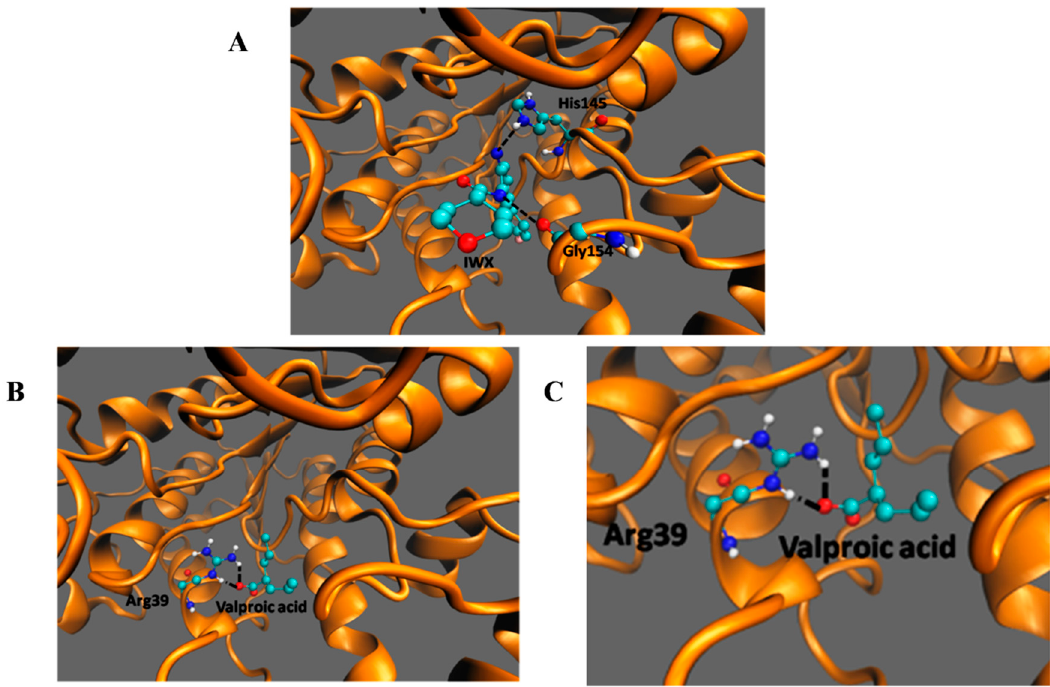
Figure 6. Docking of IWX, and VPA, with HDAC2.Molecular interaction of HDAC2 with ( A ) IWX inhibitor, docking control, ( B , C ) VPA. The black dashed lines indicate the interactions of the ligand with the labeled amino acid residues.